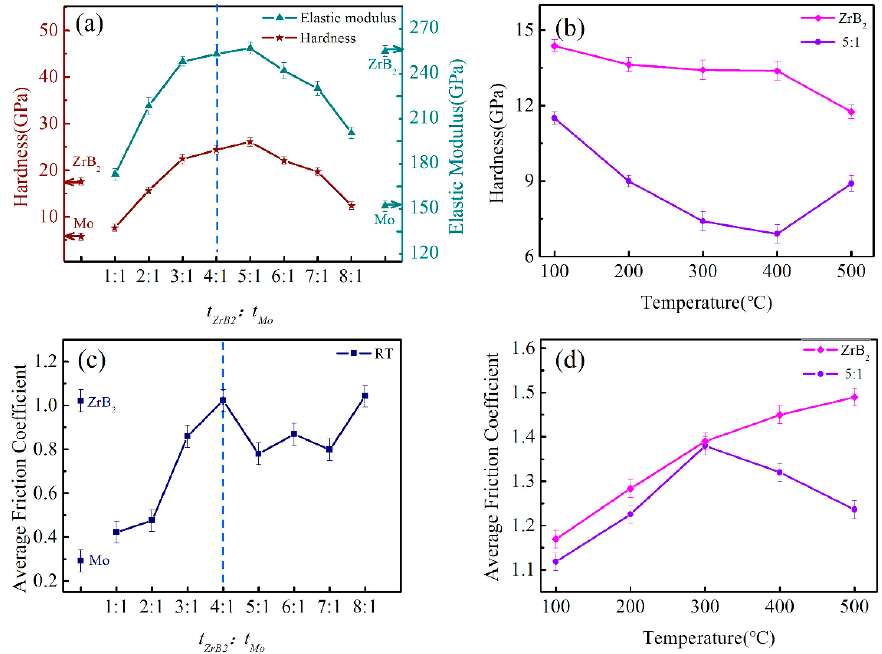
Figure 8. The hardness, elastic modulus ( a ) and friction coefficient ( c ) of ZrB 2 /Mo multilayers with different modulation ratios at room temperature, as well as the hardness ( b ) and friction coeffi- cient ( d ) of ZrB 2 and ZrB 2 /Mo ( t ZrB2 :t Mo = 5:1) at different temperatures. ( d ) of ZrB 2 and ZrB 2 /Mo ( t ZrB2 : t Mo = 5:1) at different